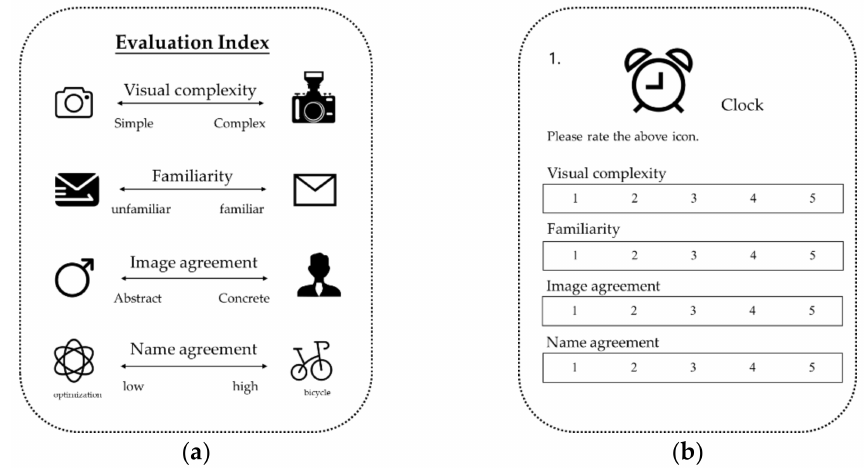
Figure 3. ( a ) Experimental evaluation index: visual complexity, familiarity, image agreement, and name agreement; ( b ) evaluation